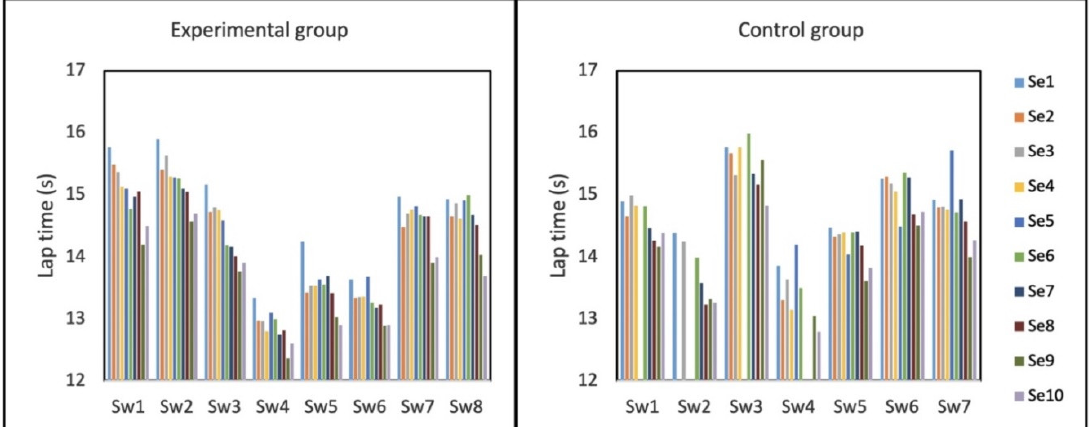
Figure 5. Average lap time of the swimmers in 10 sessions (Se1–Se10), for eight swimmers of the experimental group (Sw1–Sw8, ( left )) and seven swimmers of the control group (Sw1–Sw7, ( right )).